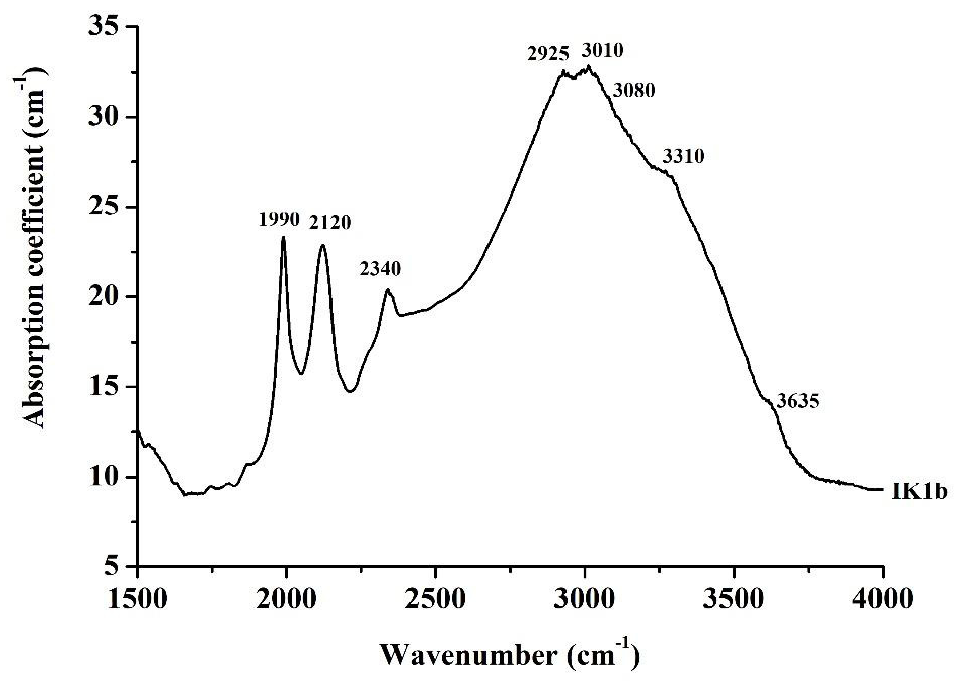
Figure 5. FTIR spectrum of the sample IK1b.